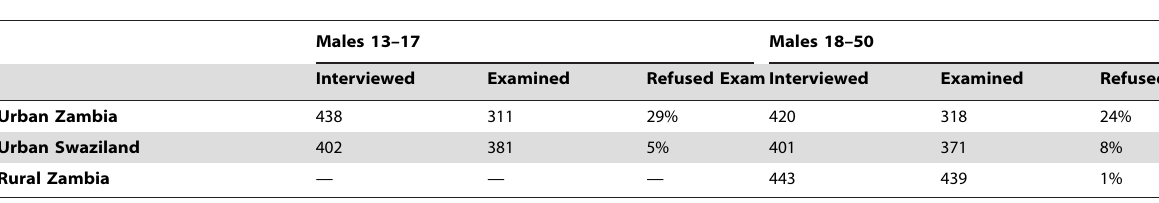
Table 2. Visual examination refusal